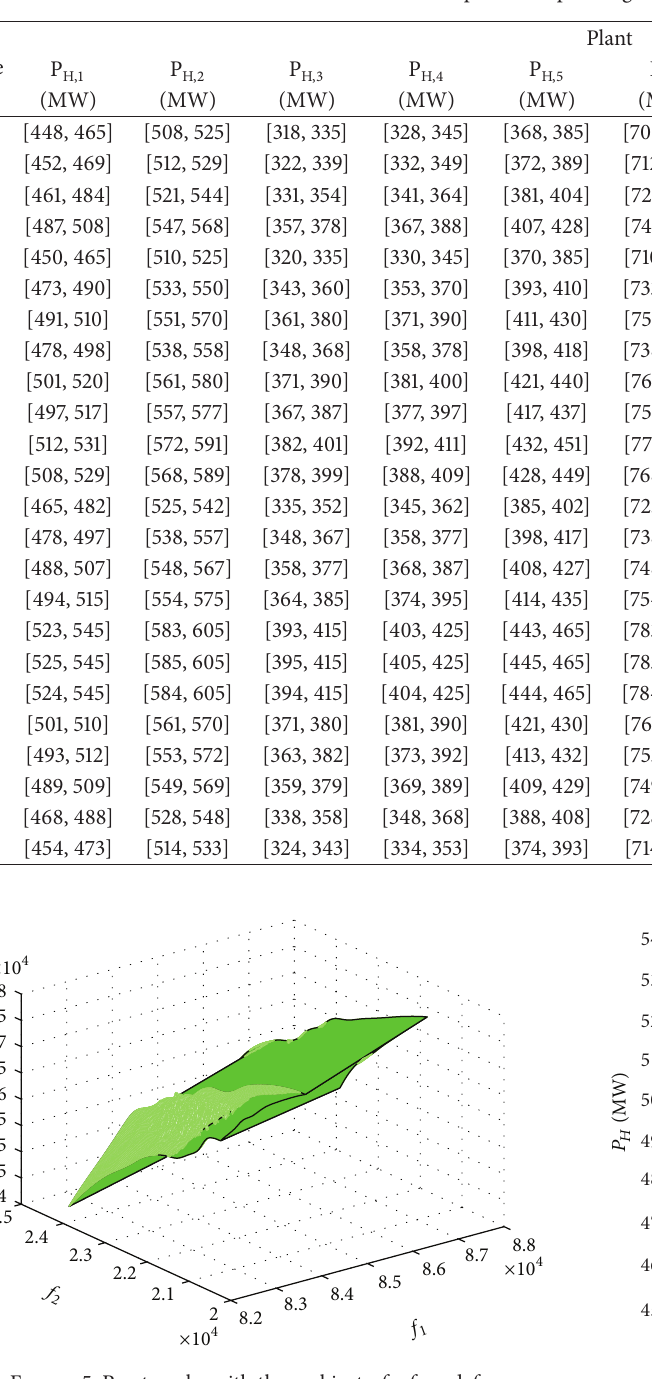
Figure 6: The optimal output range of Hydropower